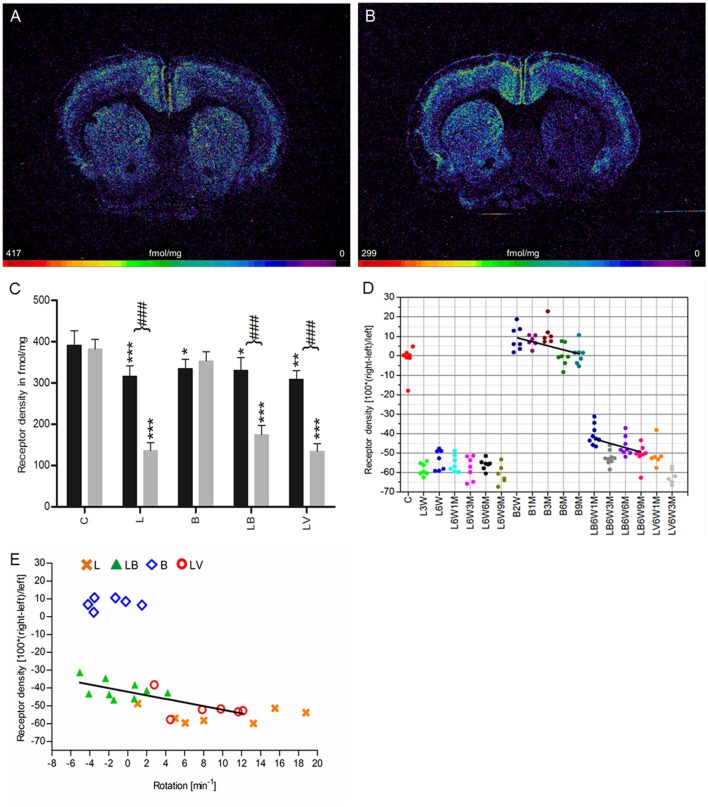
(A,B) Contrast-enhanced color-coded images showing the regional distribution of nicotinic α4β2 receptor density labeled with [3H]epibatidine in a control rat (A,B) after 6-OHDA lesion (group L6W3M) in a control rat (A) and after 6-OHDA lesion (group L6W3M) (B). (C) Mean receptor density (fmol/mg protein; averaged over all post-lesion survival times) in the left/contralateral (black column) and right/ipsilateral hemispheres (gray column) of the five groups (see Figure 1). All data is expressed as means ± SD. Asterisks mark significant differences to the respective side of controls (*p < 0.05, **p < 0.01, ***p < 0.001). Rhombs signs highlight interhemispheric significance within each group (###p < 0.001). (D) Scatter plots and regression analyses of the right-left differences of M2 receptor density for all 18 groups and time points (five groups with different survival times); see Table 1 for explanation of abbreviations. Significant regressions are labeled by a continuous line. (E) Relationship between interhemispheric differences in the α4β2 receptor densities of groups (LB and LV) and rotational behavior (anti-clockwise: +, clockwise: –).